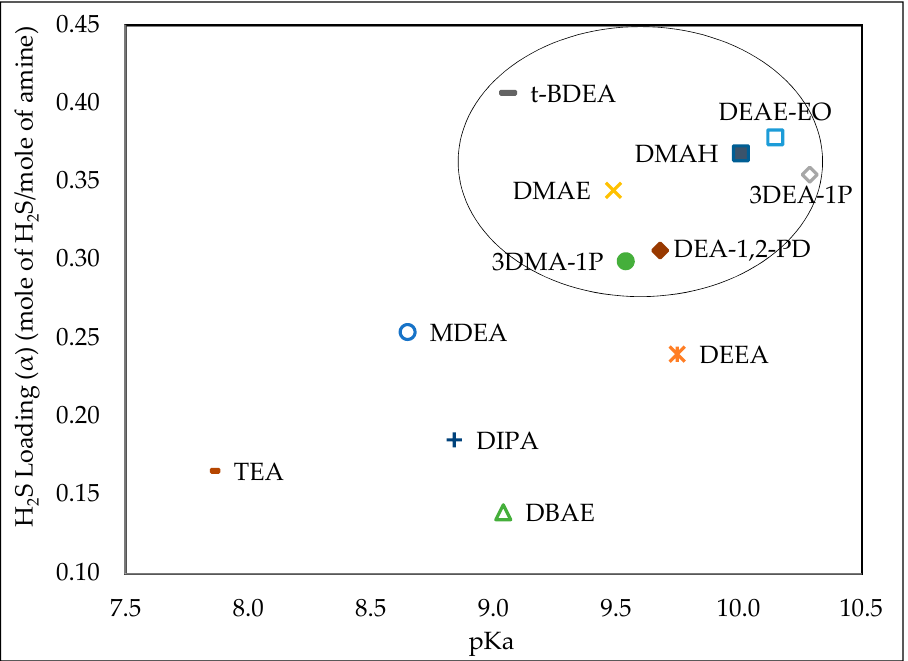
Figure 3. Effect of pKa on H 2 S loading in aqueous amine solutions; T = 5 °C ± 0.1 °C; pH 2 S = 1 kPa; amine concentration = 20 wt.% (unloaded); DBAE solutions make two phases.